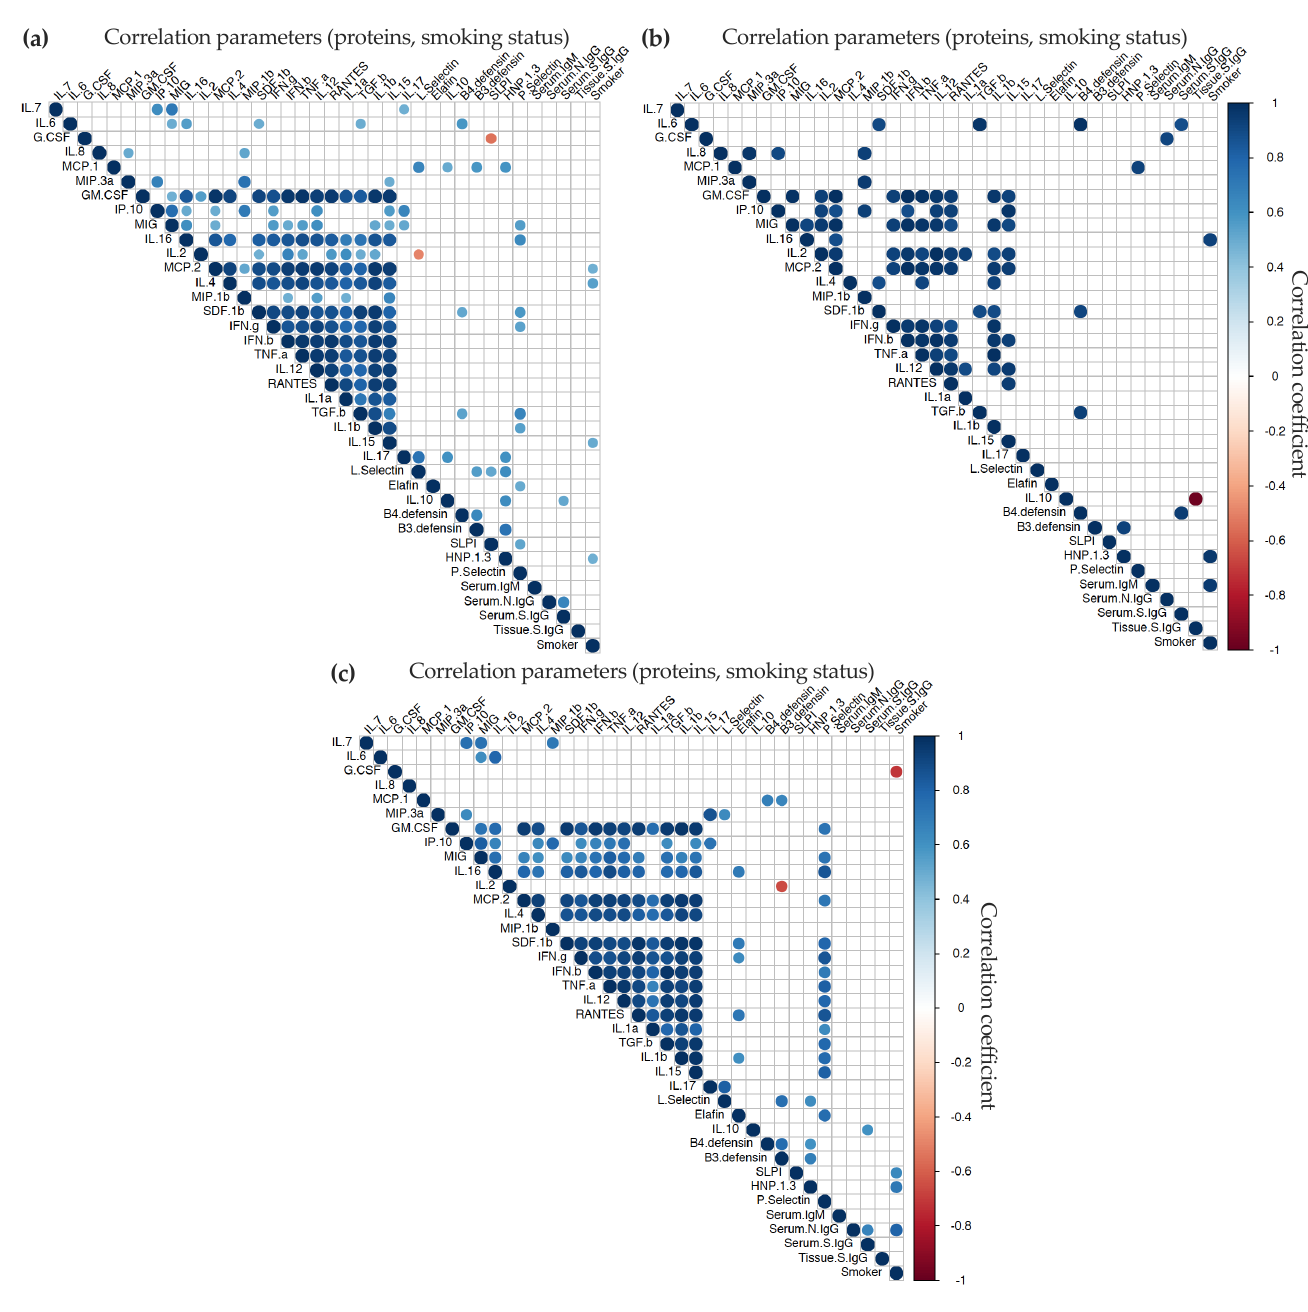
Figure 4 . Correlogram of significant responses elicited systemically. Significant (p < 0.05) correlations between concentrations of plasma cytokines/chemokines, serum and tissue Ab levels and smoking-status for all participants ( a ), vaccine-naïve ( b ) or BioNTech/Pfizer- vaccinated participants ( c ) were analyzed by a correlation matrix. Positive Pearson correlations coefficients are displayed in blue and negative correlations in red color. The color intensity indicated in the side bar is proportional to the correlation coefficient. The size of the circle is proportional to the statistical significance of the correlation.